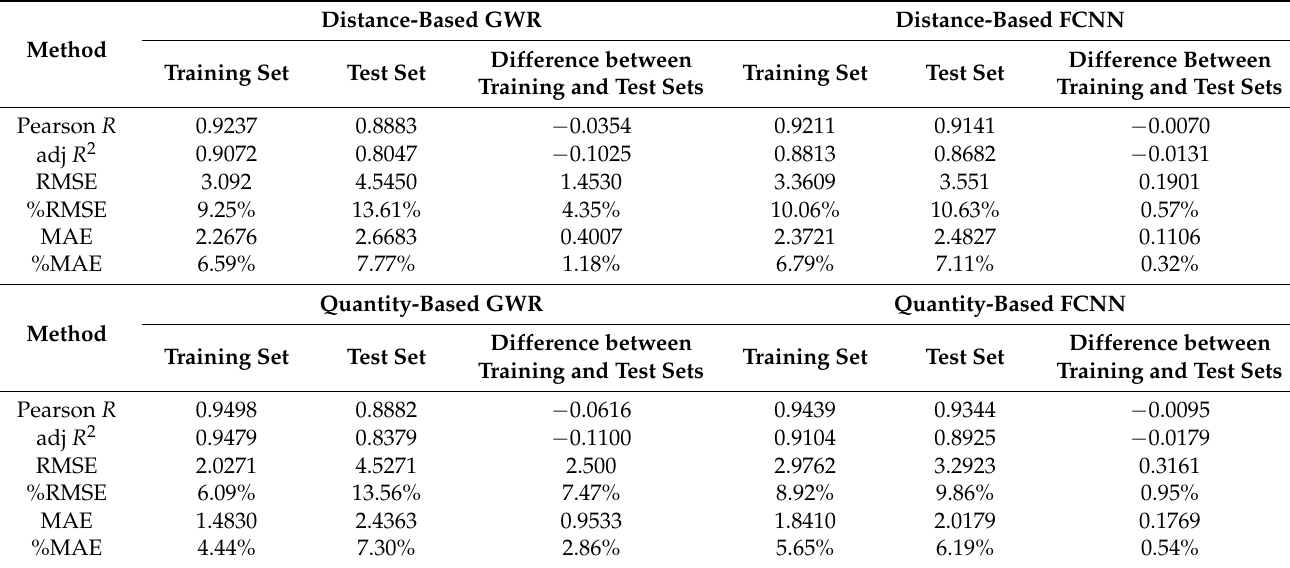
Table 5. The performances of GWR and FCNN in the training set and the test set of